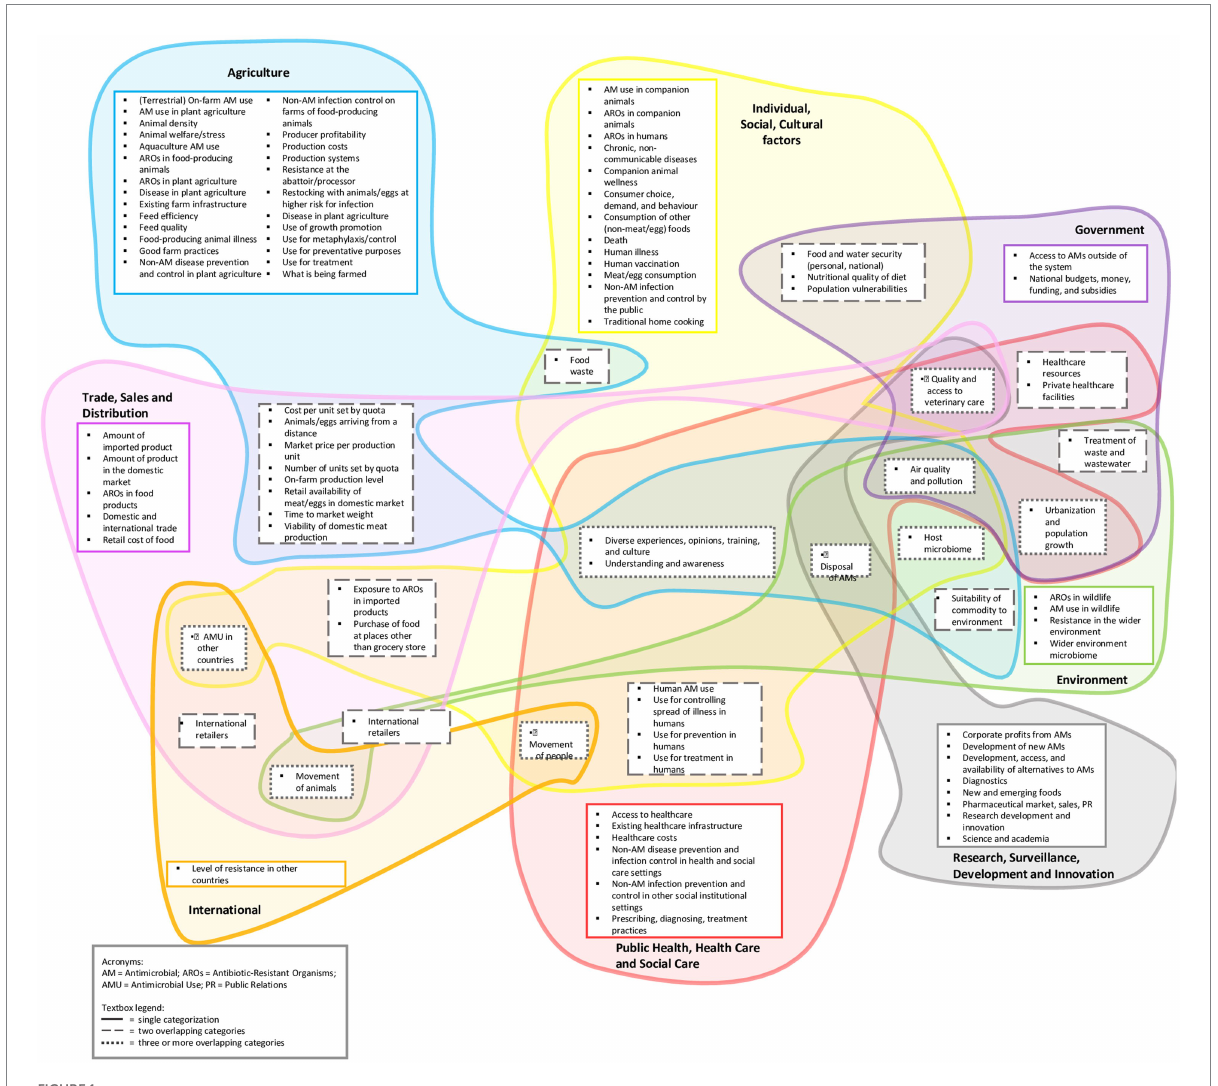
FIGURE 1 Ninety eight CLD factors grouped into eight One Health